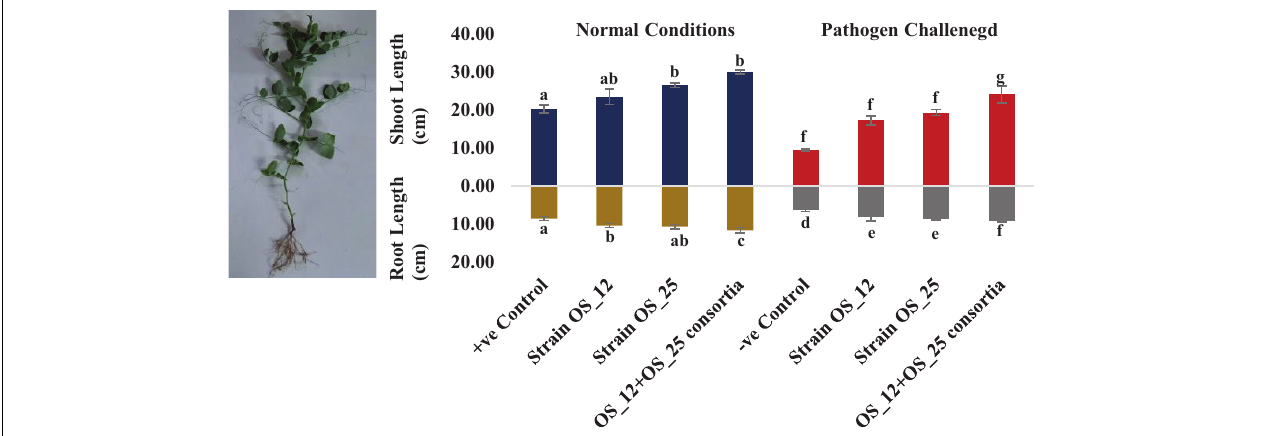
FIGURE 7 | Effect of seed biopriming with endophytic biostimulant strains OS_12 and OS_25 plants on length parameter of root and shoot biomass of pea plants sown in plastic pots under normal (dark blue and dark yellow bars) and pathogenic F. oxysporum stress (red and gray bars) conditions. Columns represent Mean values ± standard deviation ( n = 3 replicates per treatment). Different letters indicate statistical difference between treatments (Turkey’s posttest, P < 0.05) in root length and shoot length under normal and biotic stress conditions.